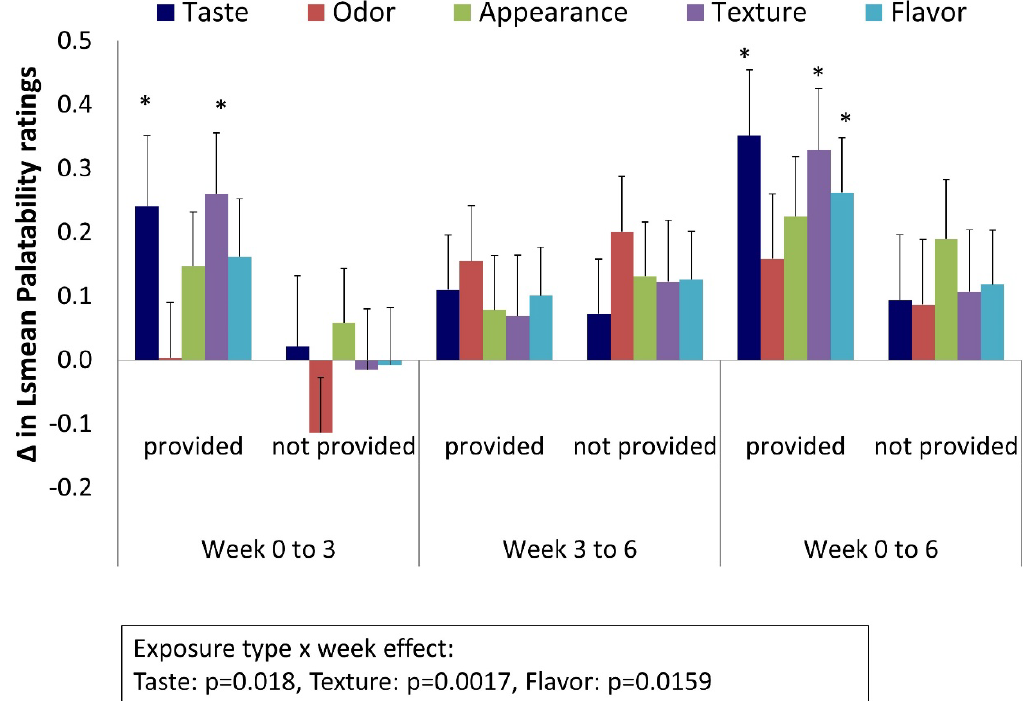
Figure 2. Changes in palatability ratings over the six-week pulse intervention in provided and not provided foods. Changes were calculated by subtracting the adjusted mean at the earlier time point from the later time point. Values are presented as least square (LS) mean ± SEM (standard error of the mean). * There were significant week by exposure type interaction effects for taste ( p = 0.018), texture ( p = 0.002), and flavor ( p = 0.016) (see Table 2 for p -values for changes from weeks 0 to 3 and weeks 0 to 6).